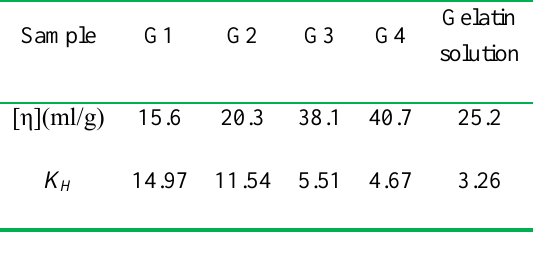
Table 3. Huggins constants and intrinsic viscosities of the investigated systems at T=25  C